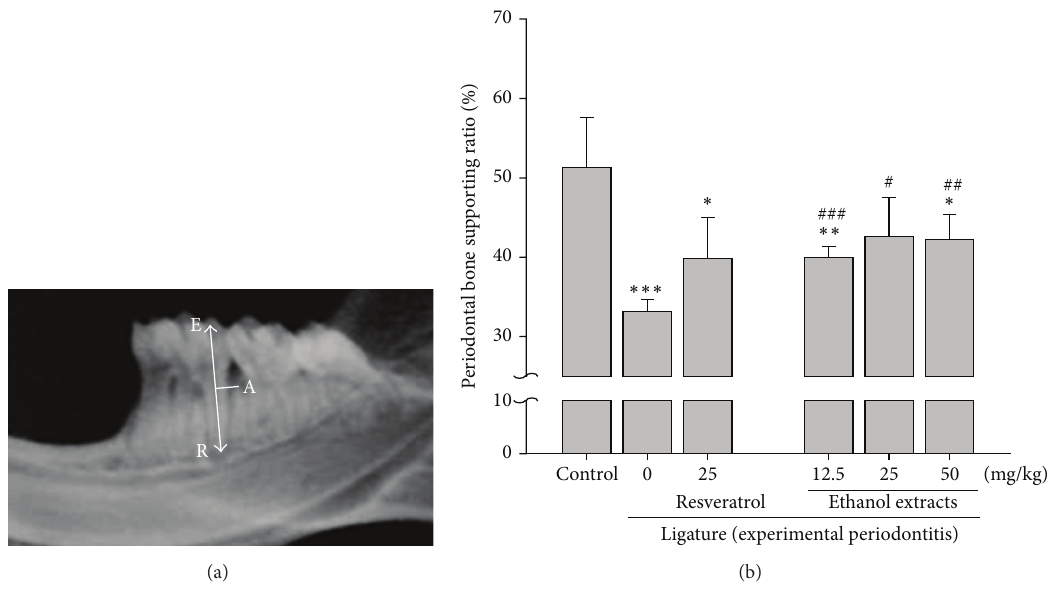
Figure 7: P. Multiflori ethanol extracts attenuated ligature-induced experimental periodontitis. Rats were performed ligature-induced experimental periodontitis at first molar and then fed with resveratrol (25mg/kg/day dissolved in 50% ethanol), ethanol extracts (12.5, 25, or 50 mg/kg/day dissolved in 50% ethanol), or 50% ethanol by gavage for 7 days. (a) The periodontal bone-supporting ratio was measured along the distal root surface and was labeled (based on measurements spanning the cusp tip, E, the deepest bony defect, A, and the root apex, R) as the A-R distance divided by the E-R distance × 100%. (b) The periodontal bone-supporting ratio was measured and shown. ( ∗ 𝑝 < 0.05 ; ∗∗ 𝑝 < 0.01 ; ∗∗∗ 𝑝 < 0.001 were compared with control group. # 𝑝 < 0.05 ; ## 𝑝 < 0.01 ; ### 𝑝 < 0.001 were compared with ligature